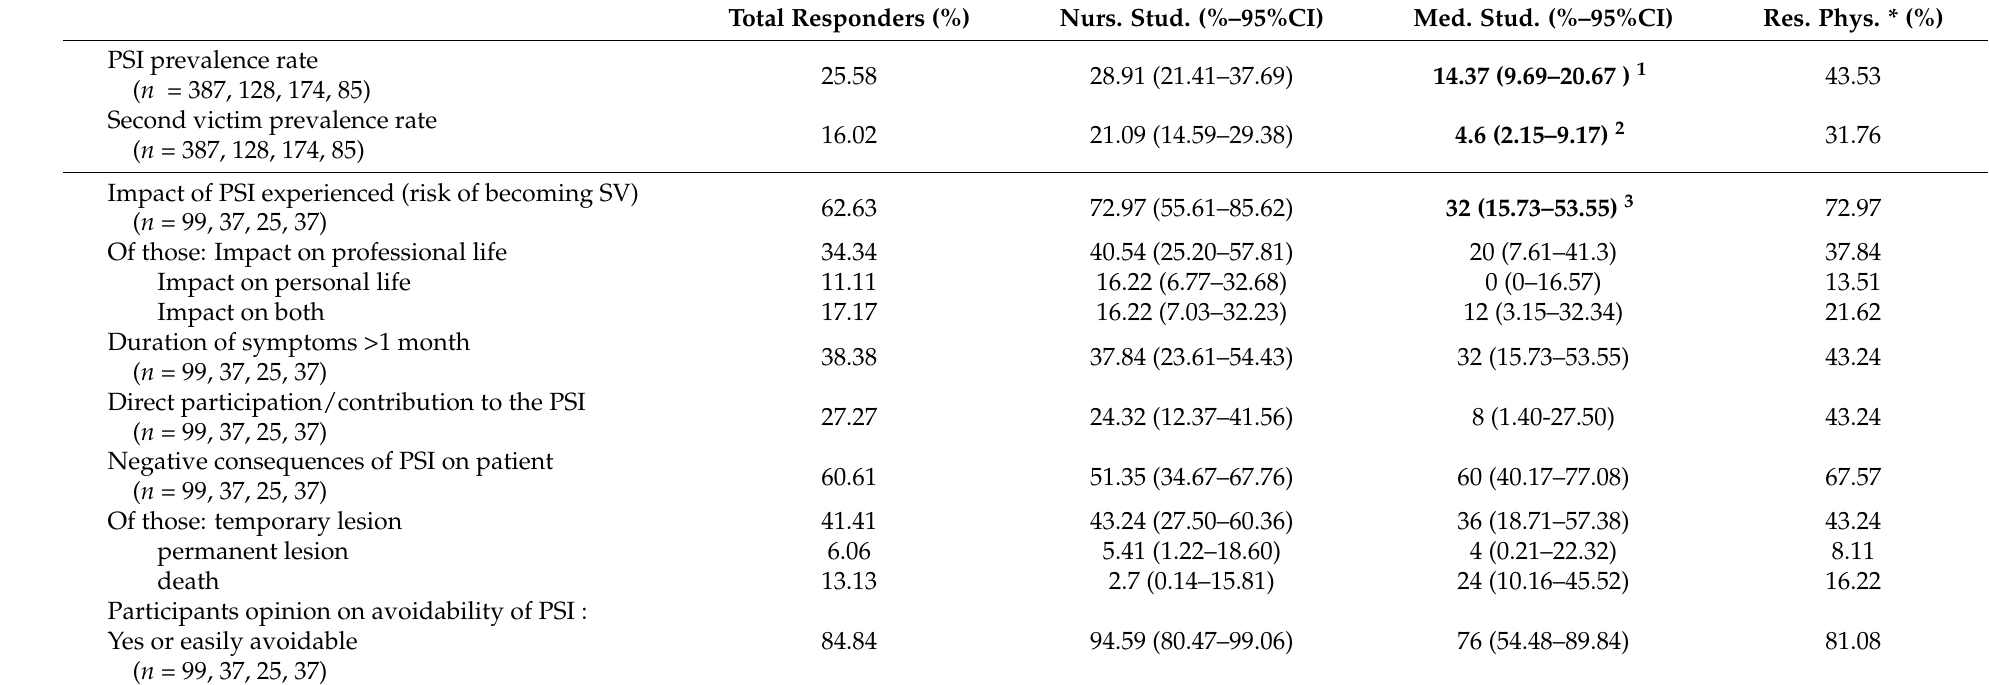
Table 2. Description of PSI and second victim phenomenon. Statistically significant results are highlighted in bold